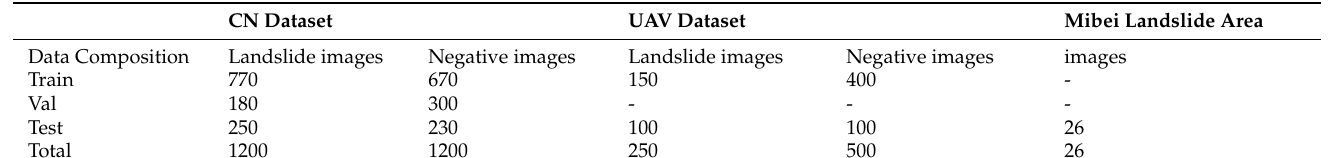
Table 3. The details of dataset division. The UAV dataset does not have validation set. The Mibei landslide area is only divided into test set for landslide detection.